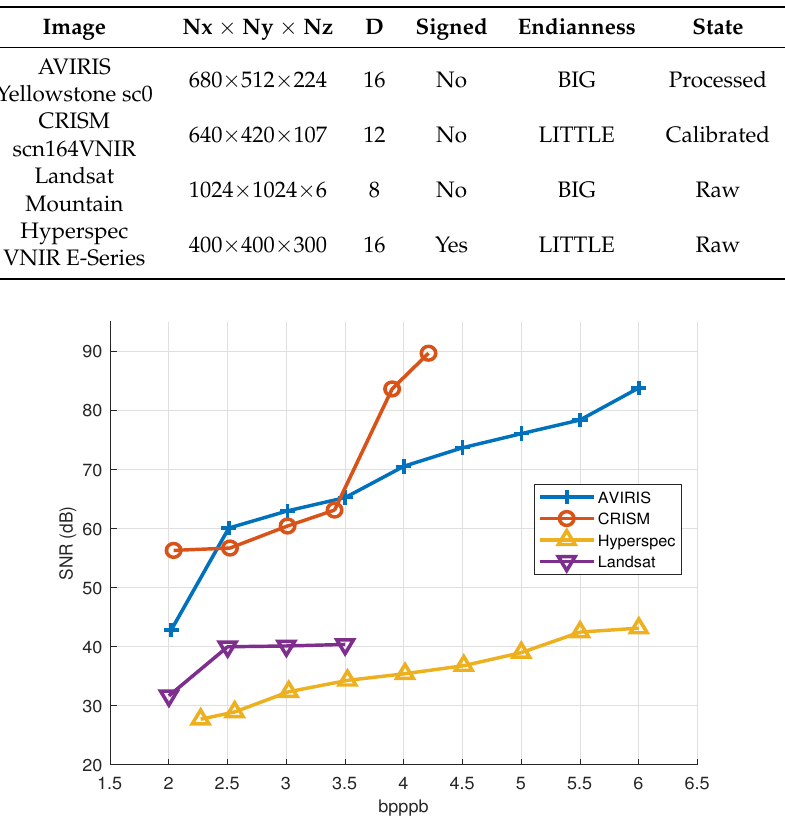
Figure 10. Compression ratio versus SNR for different sensor